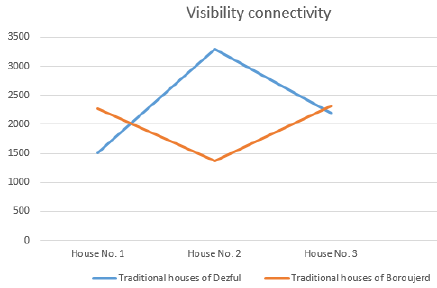
Figure 3. Measuring visual access in traditional houses of Dezful and Boroujerd (source: compiled by the authors)